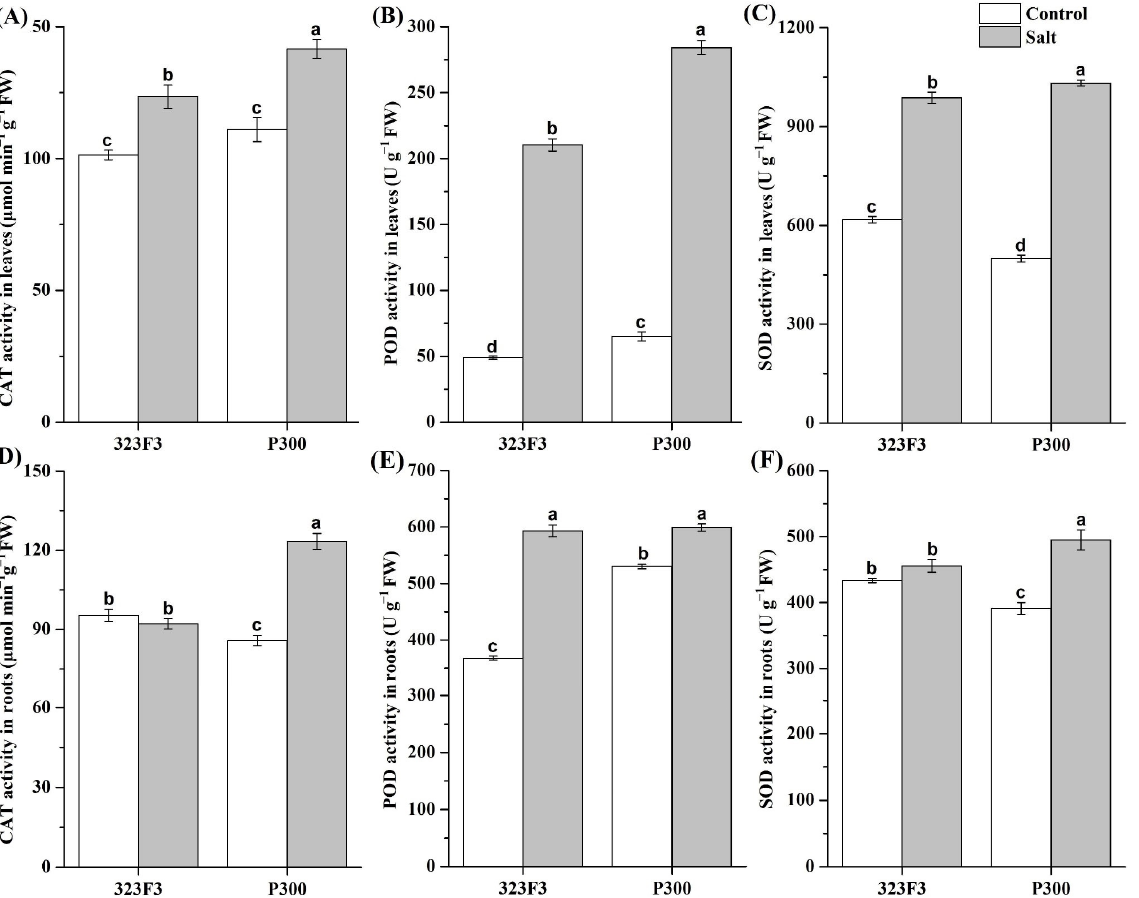
Figure 3. Effect of salt treatment on the antioxidase activities in the leaves ( A – C ) and roots ( D – F ) of 323F3 and P300. Each bar represents three biological replicates ± SD. Different small letters represent significant differences at p < 0.05 according to one-way ANOVA.